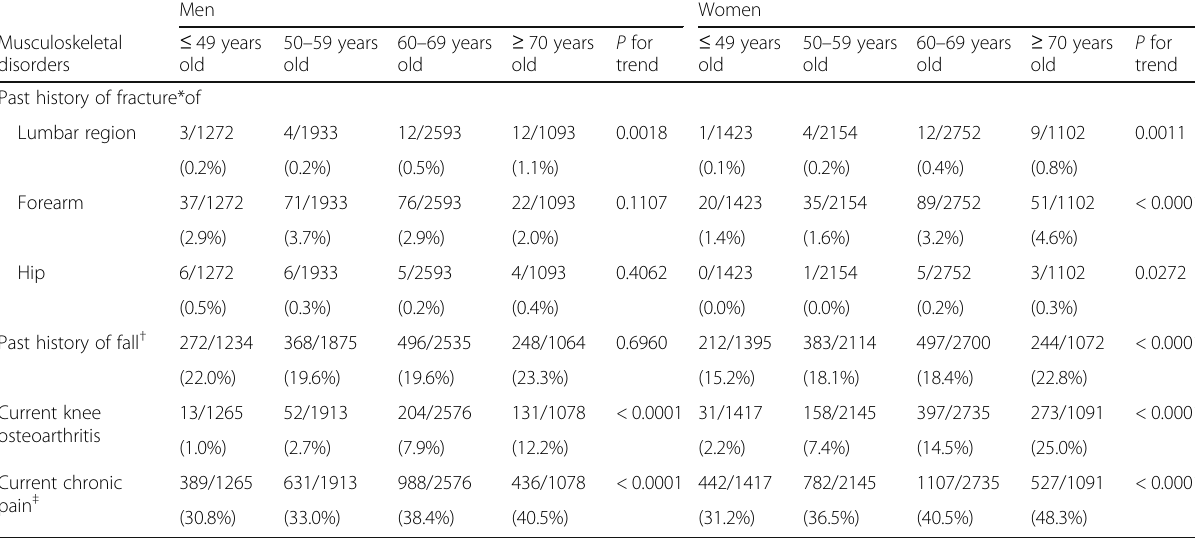
Table 3 Past or current histories of self-reported musculoskeletal events or disorders in 14,364 participants by sex and age groups